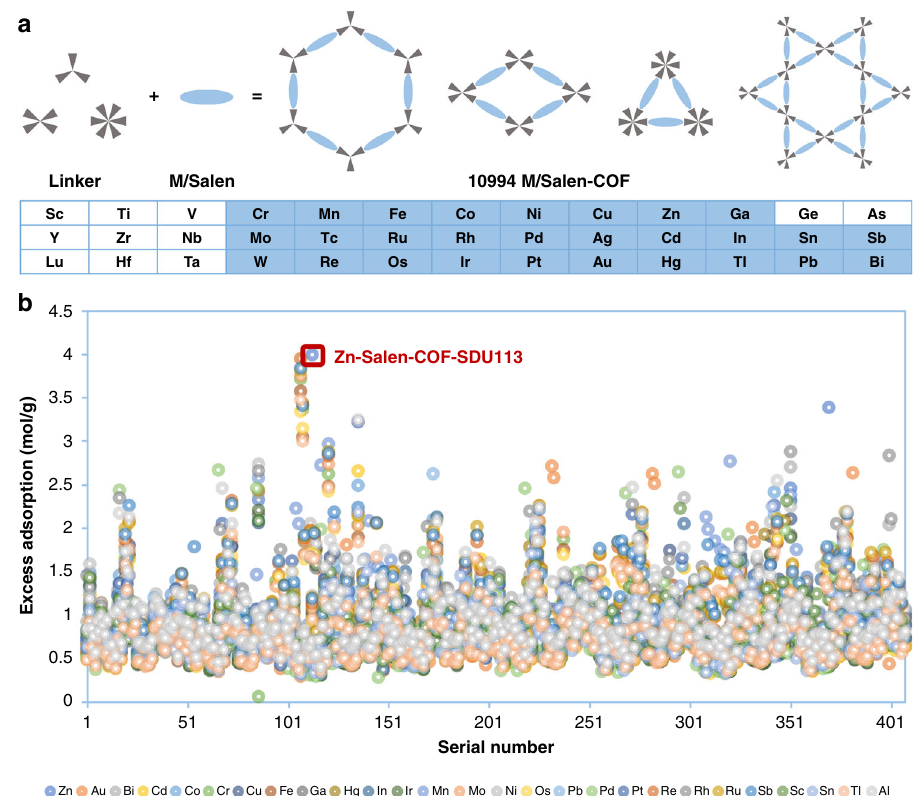
Fig. 1 Topology diagram and excess CO 2 adsorption amount. a The polygon skeletons and the metal element types for the 10994 kinds of Metal/Salen- COFs. Three types of linker groups and Metal/Salen build four topology structure, which from left to right are hexagonal, single-pore rhombic, trigonal and dual-pore kagome, respectively. The chemistry structures for all the linker groups were listed in the Supplementary Information. Twenty-eight elements were chosen as the central metal of metal/salen. b The simulated excess adsorption amount (mol g − 1 ) of CO 2 in 10994 kinds of Metal/Salen-COFs at 298 K and under 1